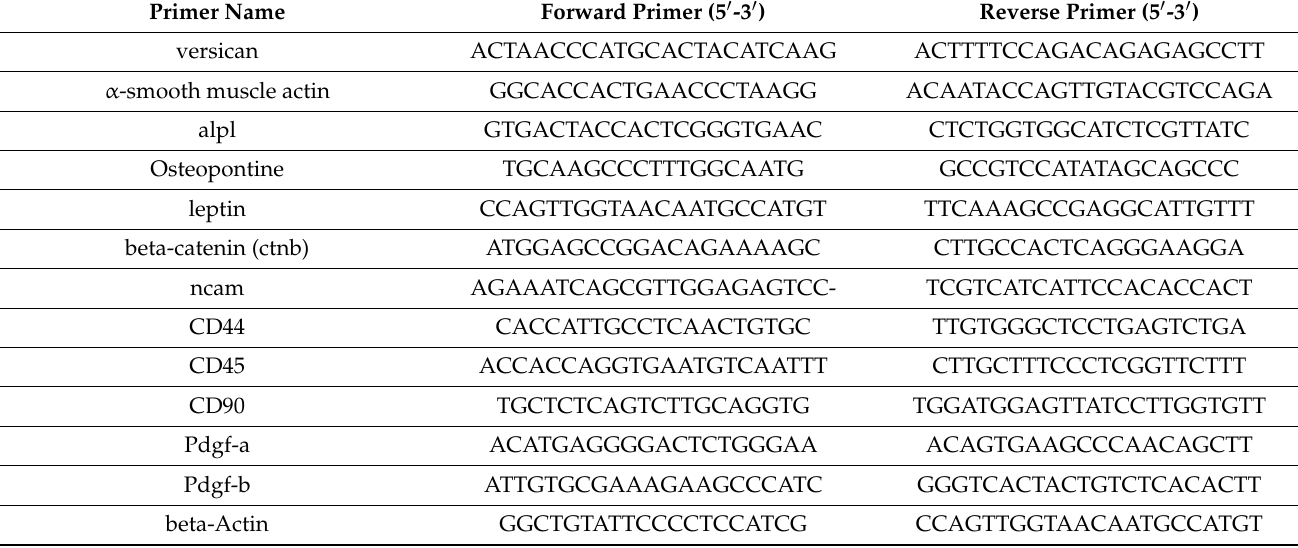
Table 1. Primer of RT-PCR.